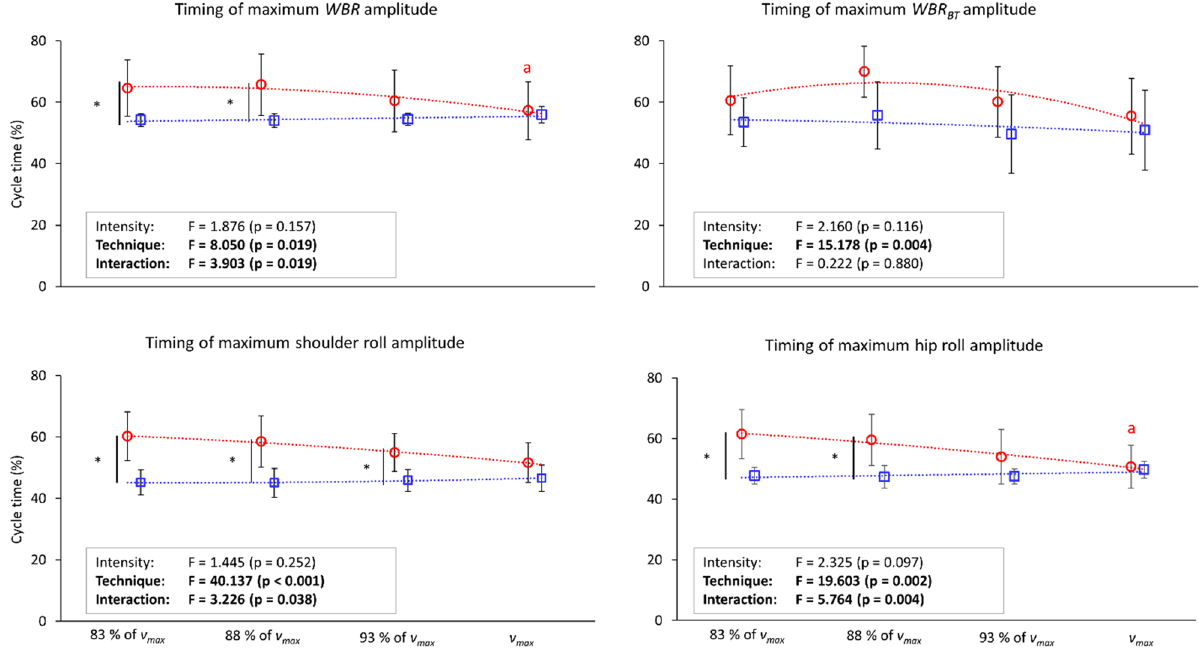
Figure 3. Maximum amplitude timing of the whole-body roll ( WBR ), whole-body roll due to the buoyant torque ( WBR BT ), shoulder roll, and hip roll at 83, 88, 93, and 100% of the maximal velocity ( v 83 , v 88 , v 93 , and v max , respectively). The red circles are front crawl data, red squares are backstroke data, and the dot lines represent trend lines based on the observed results. Asterisks show differences between the techniques, and a, b, and c show differences from v 83 , v 88 , and v 93 ,